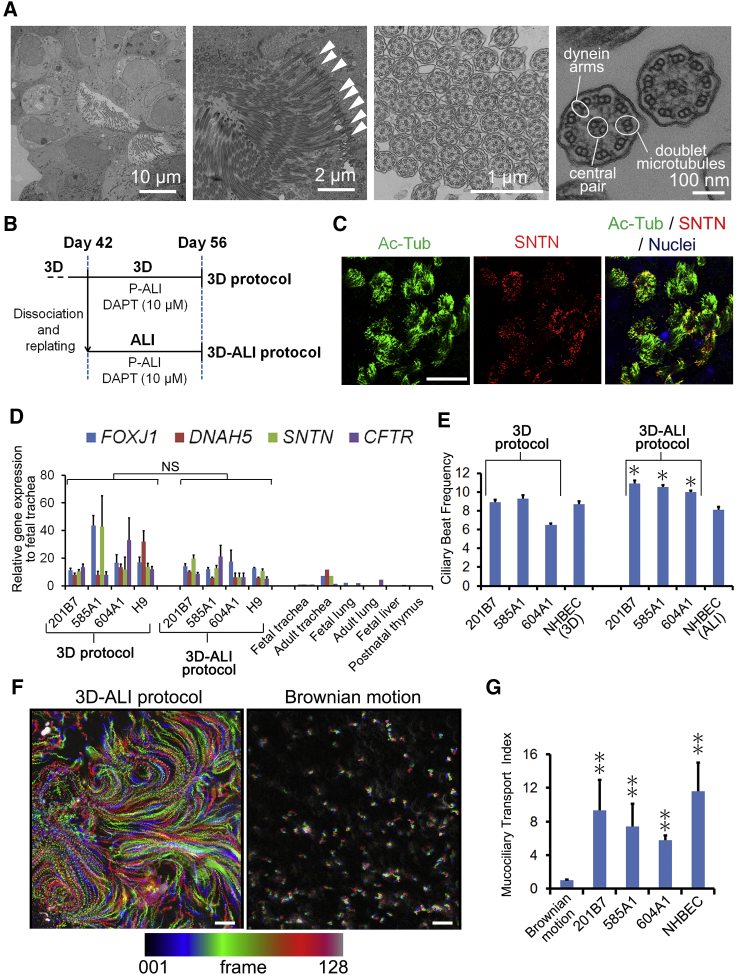
Characterization of Motile Cilia of hPSC-Derived MCACs(A) Transmission electron microscopy of DAPT-induced PAEC spheroids (201B7 hiPSCs) on day 56 (leftmost panel). Multiple cilia were originated from basal bodies (second left panel, arrowheads). A cross-sectional image of multiple cilia of induced MCACs (second right panel) was magnified to show the “9+2” structure with dynein arms (rightmost panel, circles).(B) A schematic illustration of the preparation of hPSC-derived MCACs for ciliary function tests. In the “3D protocol,” MCACs were differentiated until day 56 in spheroids. In the “3D-ALI protocol,” PAECs were dissociated from 3D Matrigel blocks on day 42, followed by replating and culturing under ALI condition until day 56.(C) Double immunostaining of Ac-Tub and SNTN in 201B7 hiPSC-derived MCACs cultured in the 3D-ALI protocol.(D) qRT-PCR of FOXJ1, DNAH5, SNTN, and CFTR expression in hPSC-derived MCACs cultured in the 3D and 3D-ALI protocols (n = 3 independent experiments). Each value was normalized to β-ACTIN. The gene expression of the fetal trachea sample was set at 1. NS, not significant.(E) The CBF of MCACs in spheroids and 3D-ALI condition in each hiPSC line in three independent experiments (n = 198, 135, and 314 cells in the spheroids and n = 174, 236, and 519 cells in the 3D-ALI condition derived from 201B7, 585A1, and 604A1 hiPSCs, respectively). NHBEC-derived MCACs were used as positive controls in each condition in three independent experiments (n = 123 and 86 in the 3D and the ALI condition, respectively). The CBF in the spheroids was compared with that in the 3D-ALI condition for each hiPSC line; ∗p < 0.05.(F) Stacked images of the fluorescent beads placed on 201B7 hiPSC-derived MCACs (left panel), and Brownian motion (right panel) acquired for 14.2 s. Color spectrum reflected time course.(G) The MTI of MCACs calculated from >100 trajectories of the fluorescent beads per sample in each hiPSC line in three independent experiments (n = 109, 142, 174, and 147 trajectories in 201B7, 585A1, and 604A1 hiPSCs and NHBECs, respectively). The MTIs in hiPSC-derived MCACs were compared with Brownian motion (n = 50) for each hiPSC line; ∗∗p < 0.01. Error bars in the qRT-PCR, CBF, and MTI analyses represent the mean ± SEM.Scale bars, 25 μm unless otherwise indicated. See also Figure S4; Movies S1 and S2; and Tables S1 and S2.